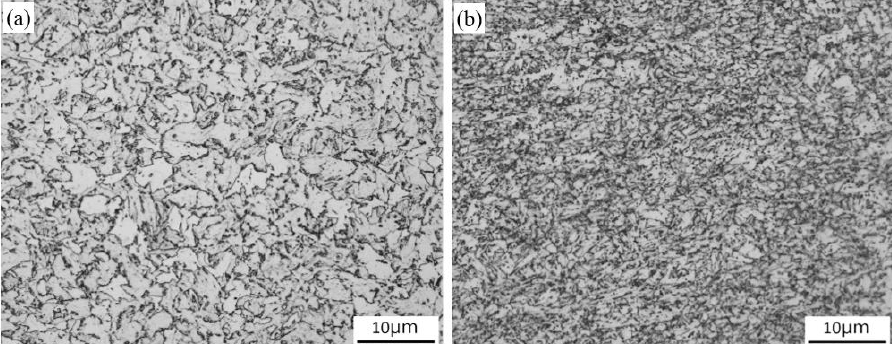
Figure 1. Microstructure of different specimens after hot rolling: ( a ) Ti steel and ( b ) Ti-V steel.